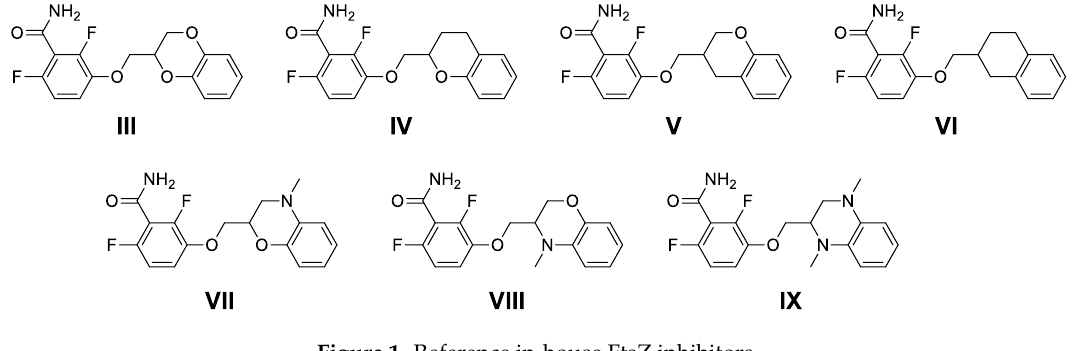
Figure 1. Reference in-house FtsZ inhibitors.